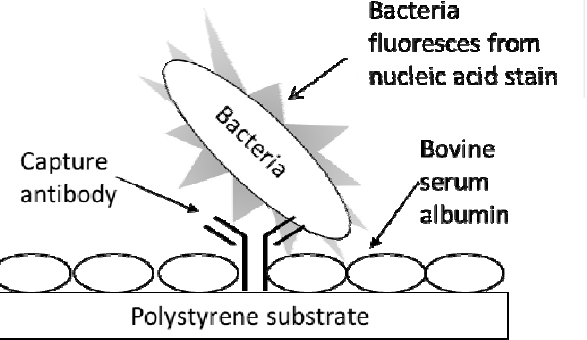
Figure 1. Schematic for the antibody-based typing microarray. Black-walled, clear-bottomed polystyrene 96-well microtiter plates were array-printed with capture antibodies, the remainder of the polystyrene surface was blocked with BSA, and bacterial sample was introduced and conferred fluorescent with a nucleic acid stain. Laser-induced fluorescence was used to detect captured